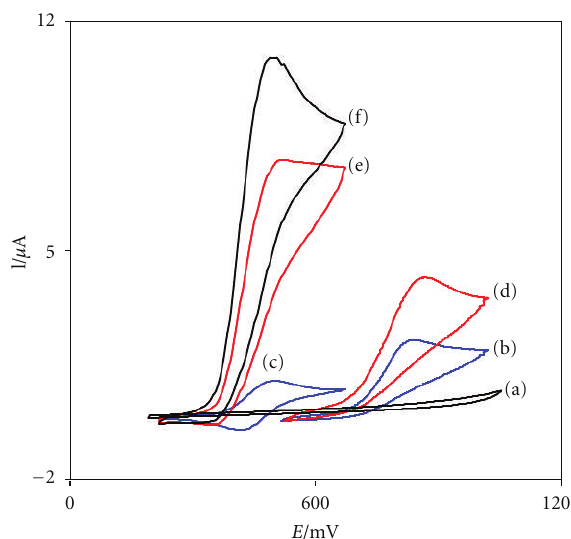
Figure 1: CVs of (a) unmodified CPE in 0.1 M PBS (pH 5.0), (b) unmodified CPE in 0.3mM CD, (c) FCDCNPE in 0.1M PBS, (d) CNPE in 0.3mM CD, (e) FCDCPE in 0.3mM CD, and (f)